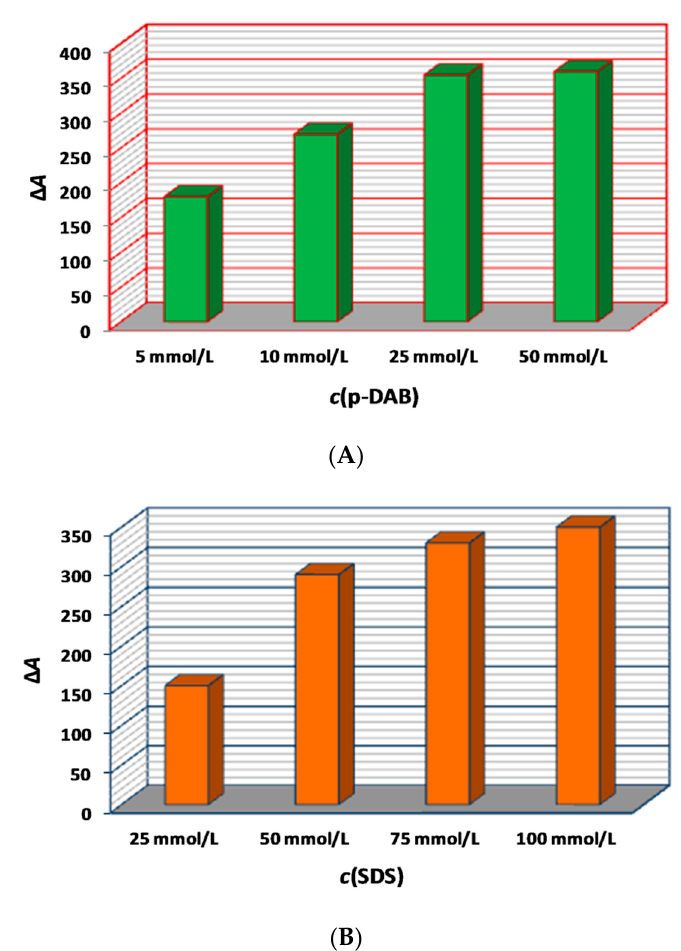
Figure 2. ( A ) Effect of the amount concentration of p -DAB. ( B ) Effect of the amount concentration of Figure 2. ( A ) E ff ect of the amount concentration of p -DAB. ( B ) E ff ect of the amount concentration SDS. of